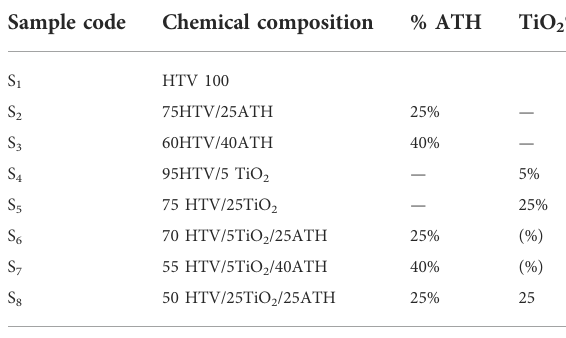
TABLE 2 Compositions and codes of the prepared shed and core composite